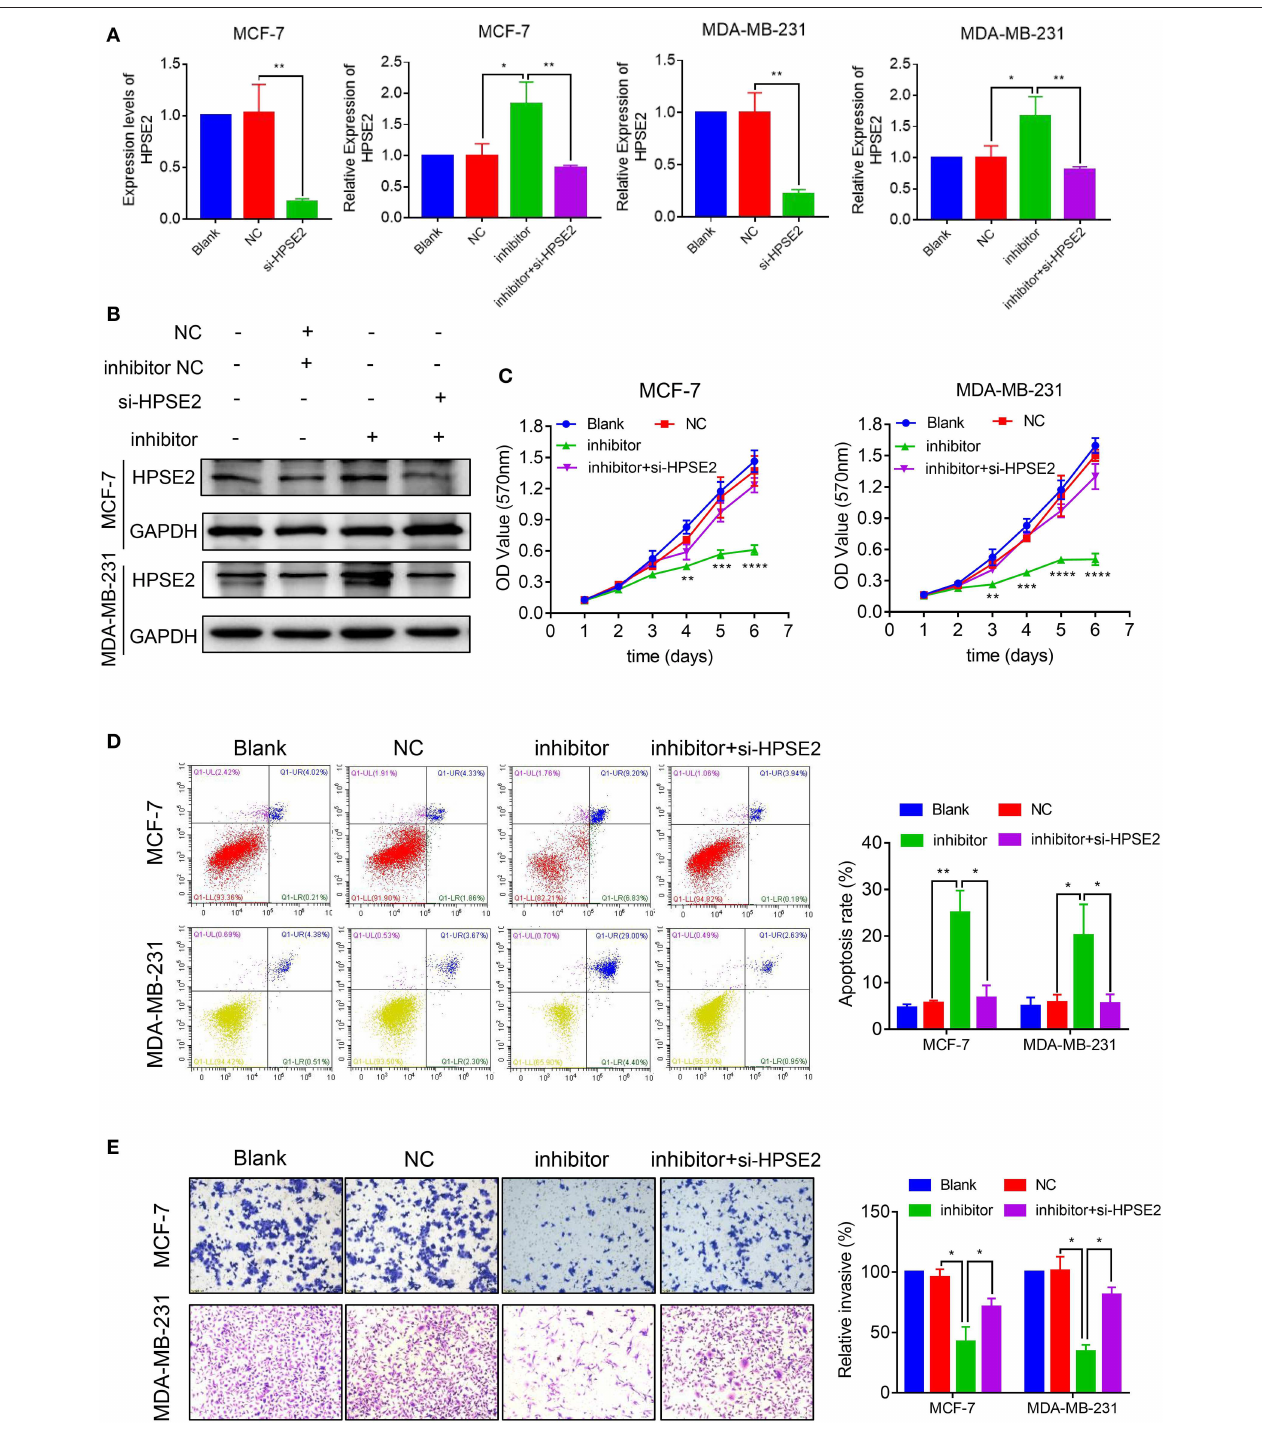
FIGURE 7 | miR-15b-5p/HPSE2 axis may modulate the breast cancer progression. (A) The mRNA level of HPSE2 in breast cancer cells underexpressing miR-15b-5p with or without the small interference RNA of HPSE2 (si-HPSE2). (B) The protein level of HPSE2 in breast cancer cells underexpressing miR-15b-5p with or without si-HPSE2. (C) 3-(4,5-Dimethylthiazol-2-yl)-2,5-diphenyltetrazolium bromide (MTT) assays showed that the effects of miR-15b-5p downregulation on breast cancer cells in inhibiting cell proliferation were significantly reversed by co-transfection of si-HPSE2. (D) Flow cytometry showed the apoptotic rates of breast cancer cells transfected with miR-15b-5p inhibitor and/or si-HPSE2. (E) The invasion of breast cancer cells underexpressing miR-15b-5p with or without si-HPSE2 (* P < 0.05, ** P < 0.01, *** P < 0.001, and **** P < 0.0001).